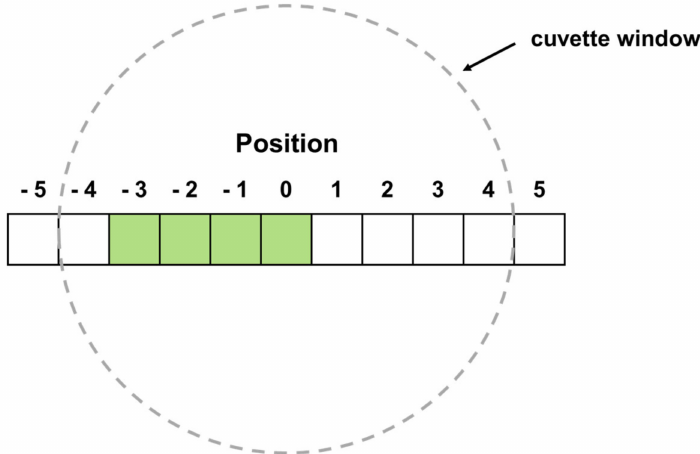
Figure 2. Cross-section of the dynamic image analysis flow-through cuvette. The horizontal axis is divided into 3.75 mm × 3.75 mm frames corresponding to the detection window. Positions 0 to − 3 (green boxes) represent the experimentally accessible areas, whereas the remaining frames are not usable due to setup